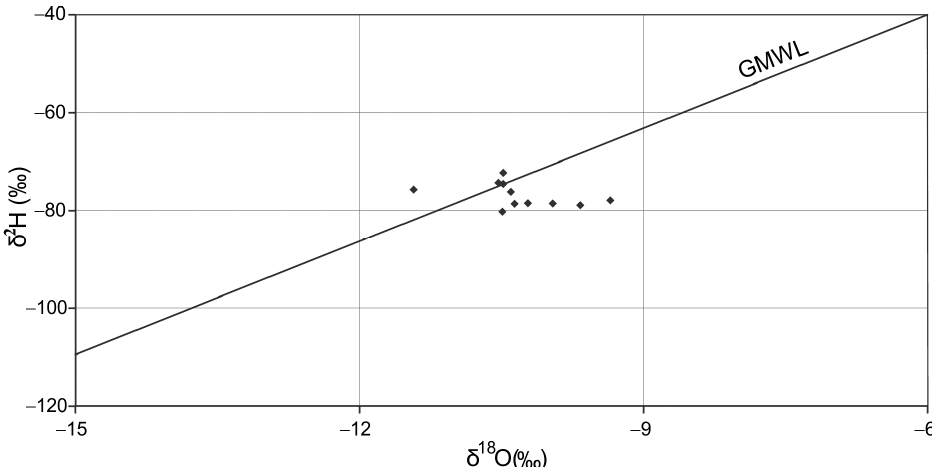
Figure 3. δ 18 O and δ 2 H determinations of the studied groundwaters in relation to the global meteoric water line ( GMWL ).